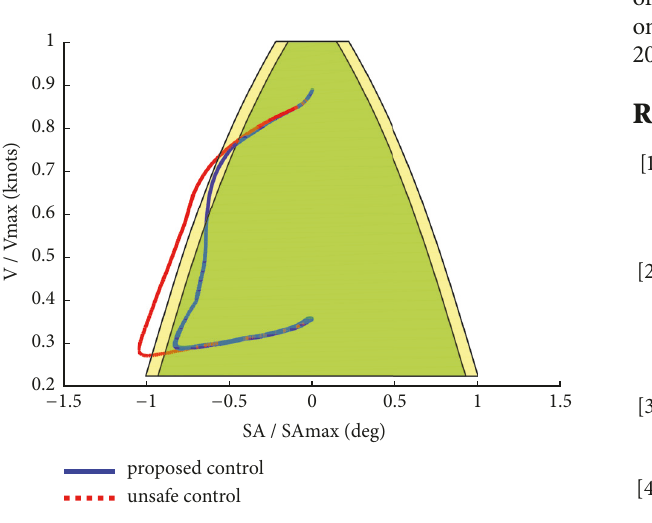
Figure 7: The variation of 𝑆𝐴 .